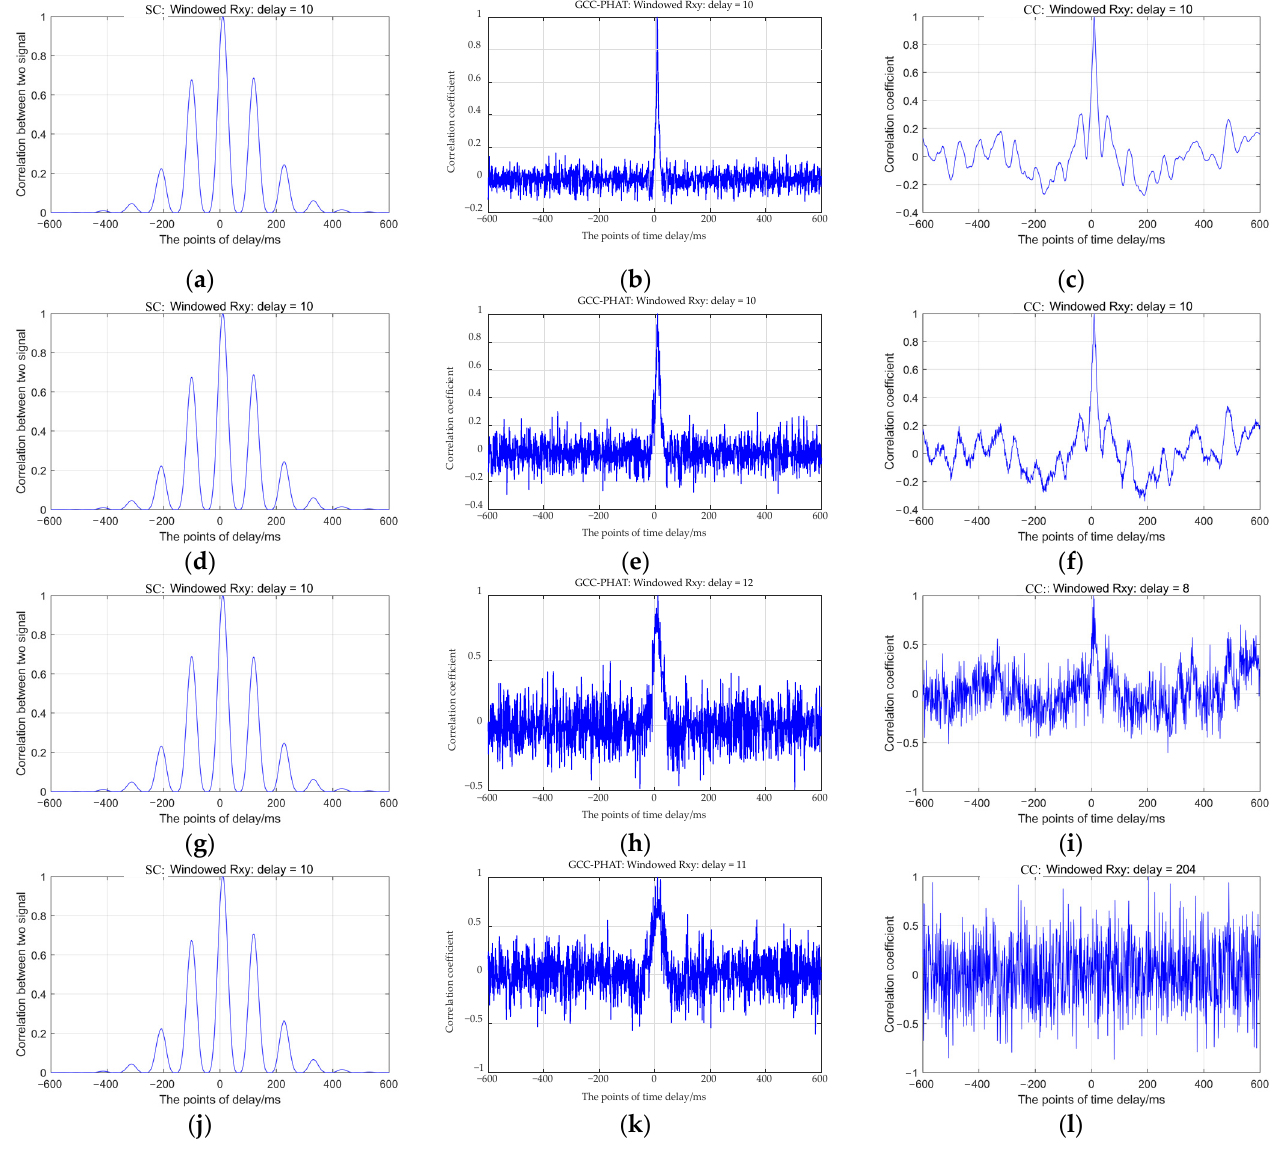
Figure 3. Time delay values calculated by the SC method: ( a ) SNR = 30 dB, delay = 10 ms, ( d ) SNR = 20 dB, delay = 10 ms, ( g ) SNR = 10 dB, delay = 10 ms, ( j ) SNR = 0 dB, delay = 10 ms; the GCC-PHAT method: ( b ) SNR = 30 dB, delay = 10 ms, ( e ) SNR = 20 dB, delay = 10 ms, ( h ) SNR = 10 dB, delay = 12 ms, ( k ) SNR = 0 dB, delay = 11 ms; and the CC method: ( c ) SNR = 30 dB, delay = 10 ms, ( f ) SNR = 20 dB, delay = 10 ms, ( i ) SNR = 10 dB, delay = 8 ms, ( l ) SNR = 0 dB, delay = 204 ms.